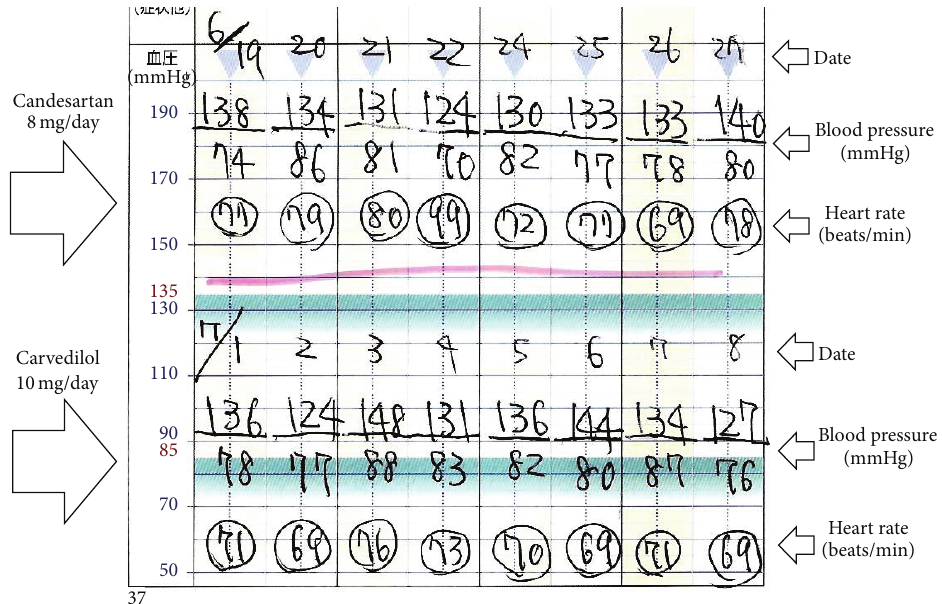
Figure 2: Self-measured blood pressure and heart rate at home under treatment with candesartan and under treatment with